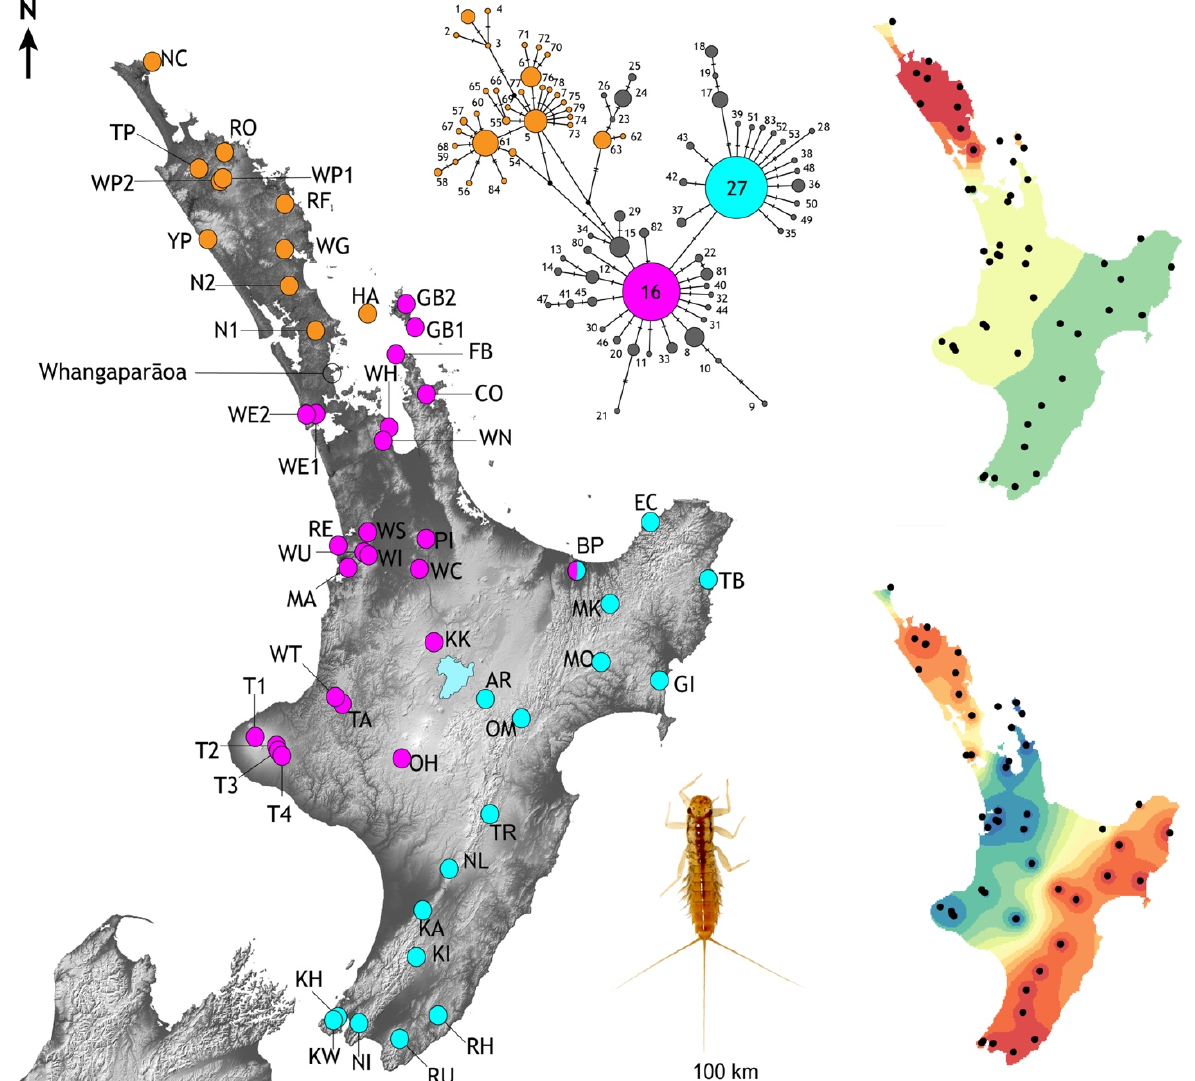
Figure 4. Distribution of mtDNA cytochrome ‐ b haplotype diversity among population samples of the mayfly Acanthophlebia cruentata in North Island, New Zealand. Spot colours show occurrences of the two most common haplotypes (#16 magenta, and #27 turquoise), and locations in the north that lack either of the common haplotypes (orange). Scarce derivates of the two common haplotypes are grey in the network (See Supplementary Table S1). This genetic variation is also depicted by interpolations of the first two global axes of spatial PCA from these data revealing overall trends in spatial structure ( right ). Inset is late instar A. cruentata nymph.